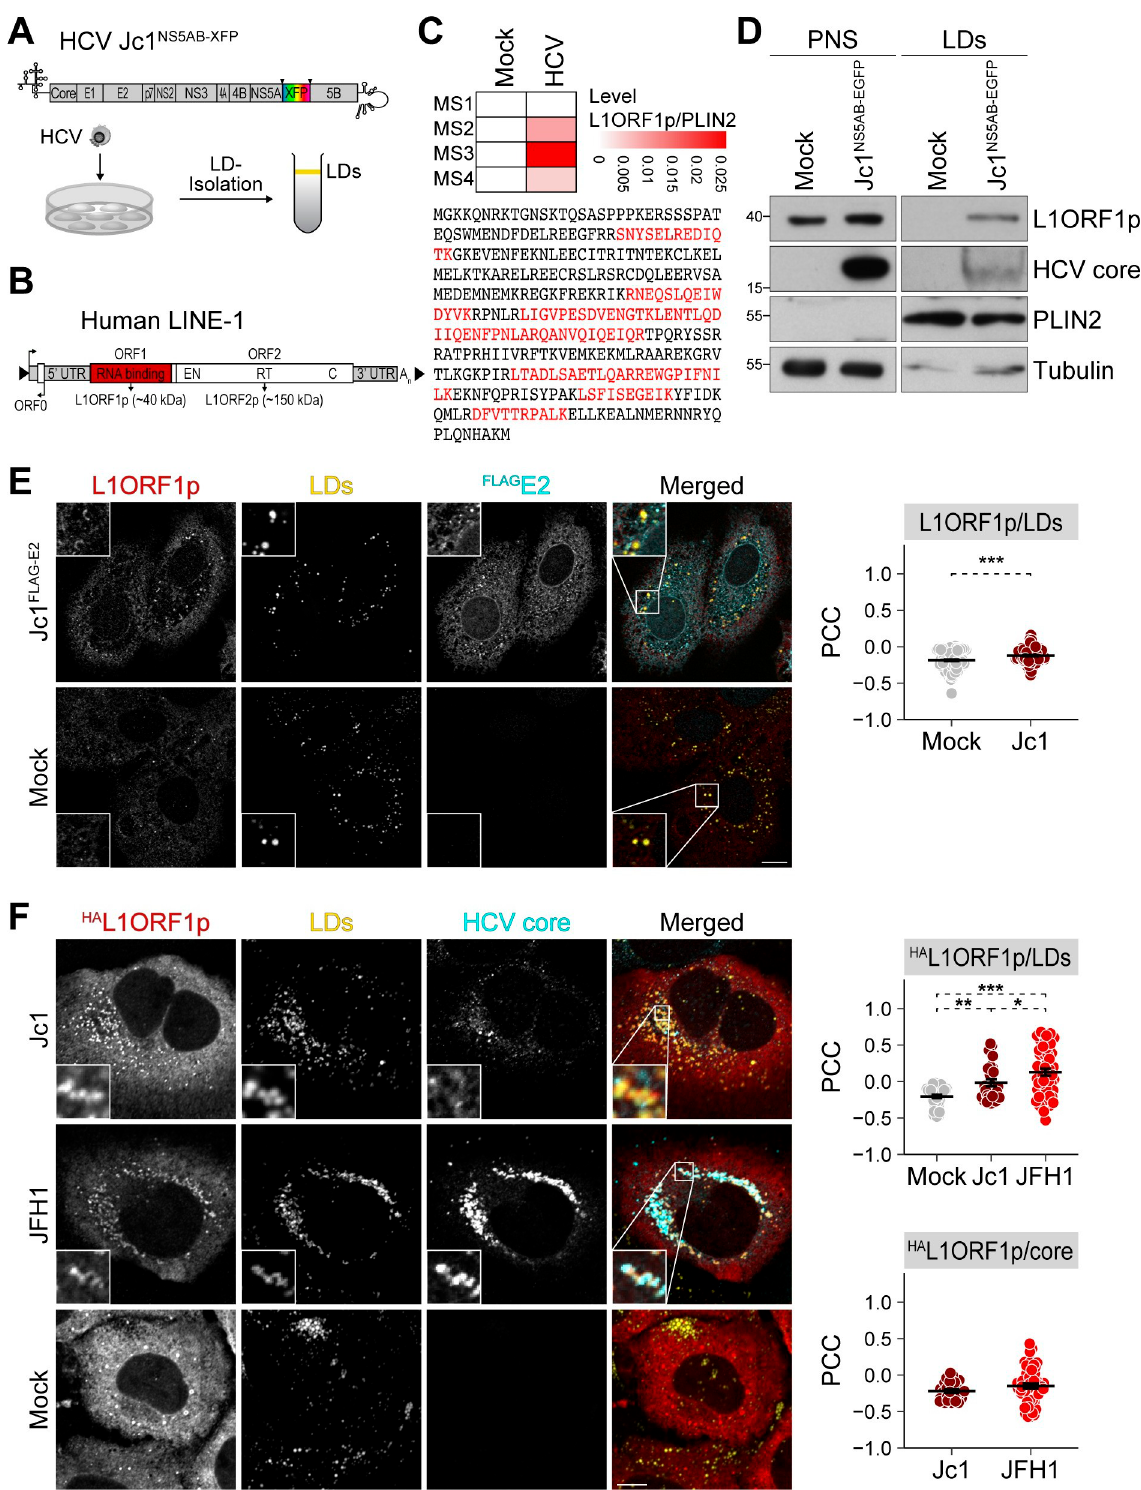
Fig 1. HCV infection re-localizes L1ORF1p to lipid droplets. (A) Experimental setup to identify lipid droplet–associated proteins. HCV Jc1 reporter constructs encode fluorescent proteins (XFP) flanked by duplicated NS5A-NS5B cleavage sites (S1 Fig). NS, non-structural protein. HCV-infected and uninfected cells were lysed and lipid droplets were isolated by sucrose density centrifugation. Proteins from the floating lipid droplet fraction were analyzed by mass spectrometry or immunoblotting. (B) Scheme depicts the organization of a functional endogenous L1